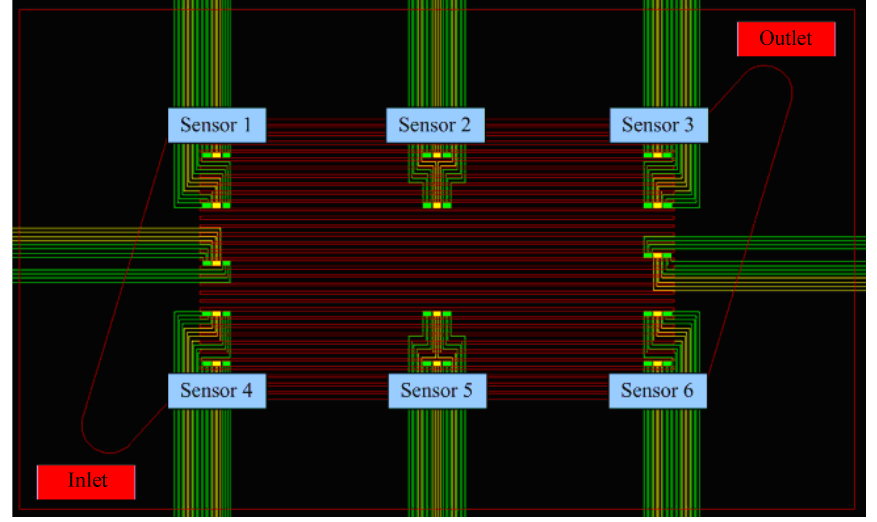
Figure 7. Distribution of micro temperature sensors during